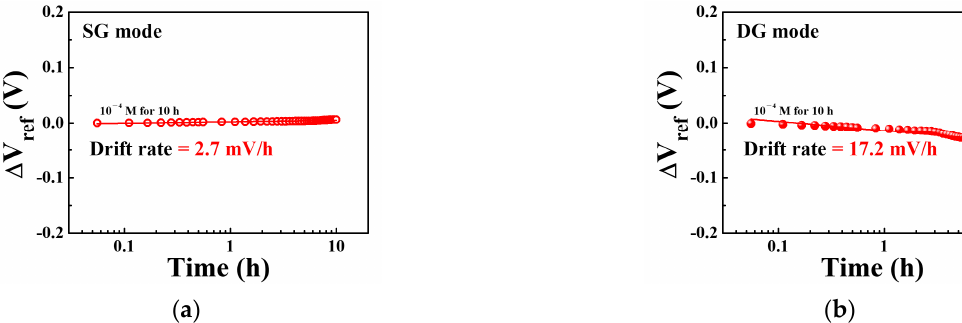
Figure 11. Drift effects of the sodium ion sensor based on SiNW channel DG FETs with a sodium-selective membrane EG after exposure to a sodium electrolyte concentration of 10 − 4 M for 10 h during the ( a ) SG mode and ( b ) DG mode operations.